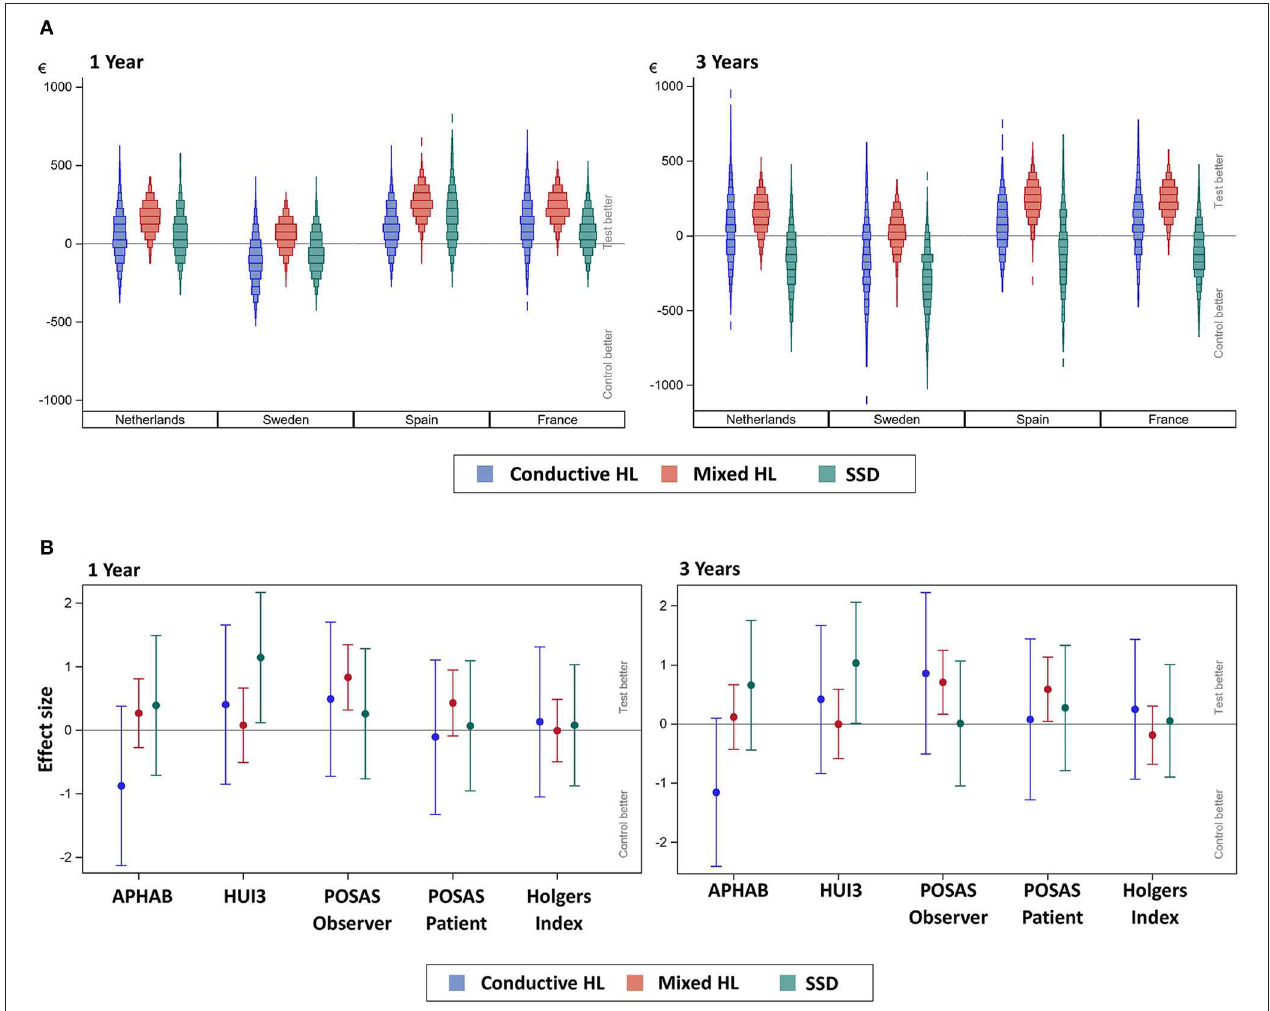
FIGURE 4 | (A) Scenario analysis—subgroup cost-consequence analysis after 1 and 3 years. The incremental mean cost per subject, per country, per subgroup as simulated using 1,000 bootstraps using unrestricted random sampling which was displayed using a density histogram. A positive number indicates a cost saving in favor for the test intervention. For this simulation all subjects per subgroup were allocated one-by-one to every of the participating countries per simulation . SSD, single-sided sensorineural deafness. (B) Subgroup cost-consequence analysis after 1 and 3 years. The effect sizes for the different outcome measures (AUCs) over the first year together with the 95% confidence interval are displayed. Note that the APHAB and HUI3 were calculated as the change from (the unaided)